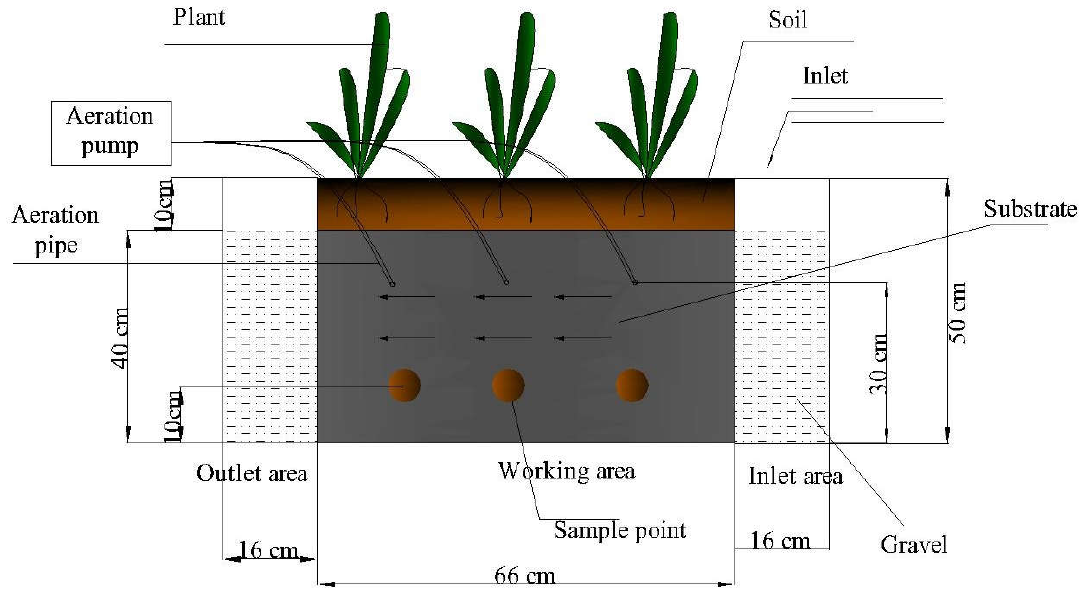
Figure 1. Experimental constructed wetland design.